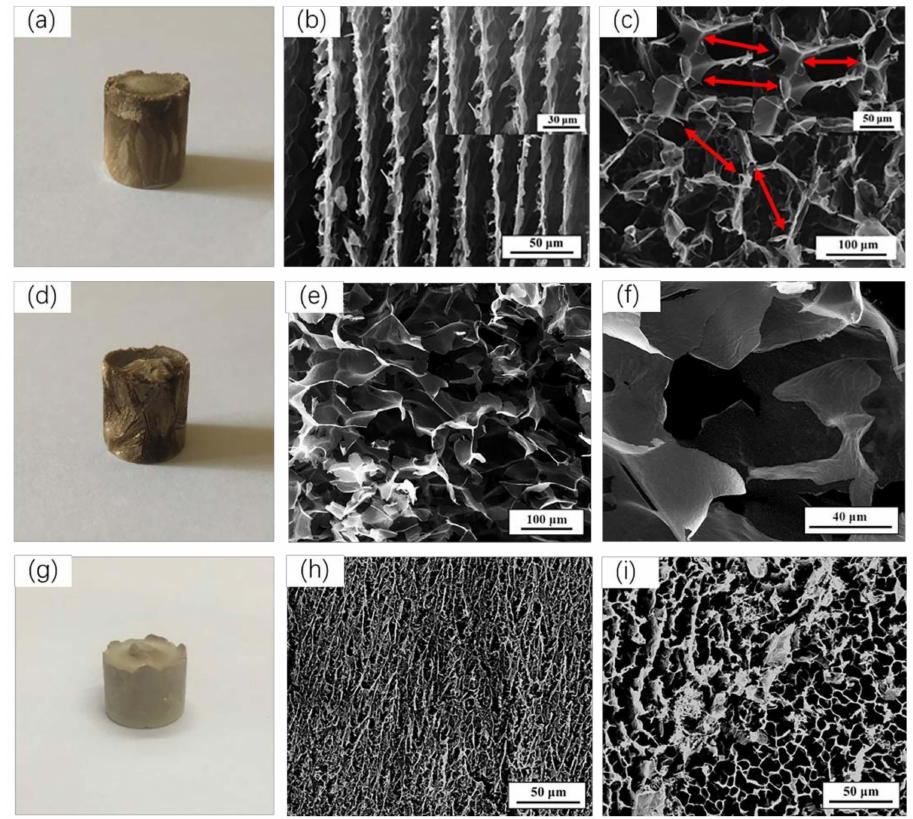
Figure 3. Macroscopic pictures and microstructures of aerogels formed by di ff erent freeze-drying methods. ( a ), ( d ) and ( g ) are macro photographs of d-MCPGA, r-MCPGA, n-MCPGA, respectively; ( b ) vertical section of d-MCPGA; ( c ) cross section of d-MCPGA; ( e – f ) internal SEM image of r-MCPGA; ( h ) vertical section of n-MCPGA; ( i ) cross section of n-MCPGA.